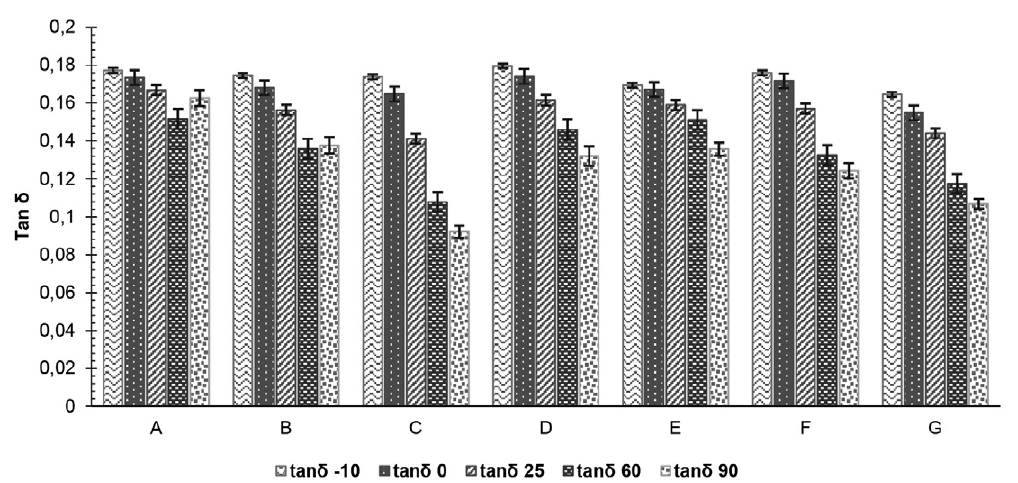
Figure 4. Loss factor (tan δ) values at different temperature of rubber samples containing various processing aid agent.